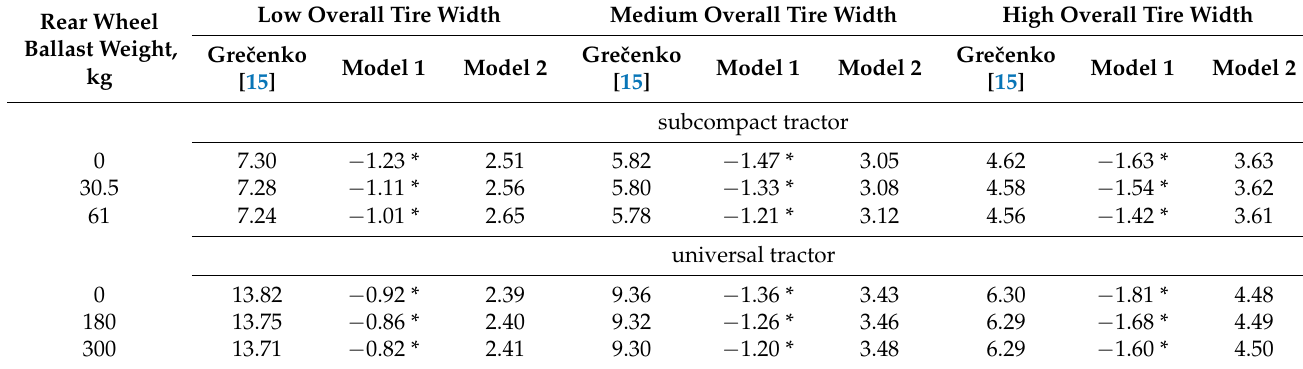
Table 5. Percentage difference (%) between [15], Model 1, Model 2, and [14].